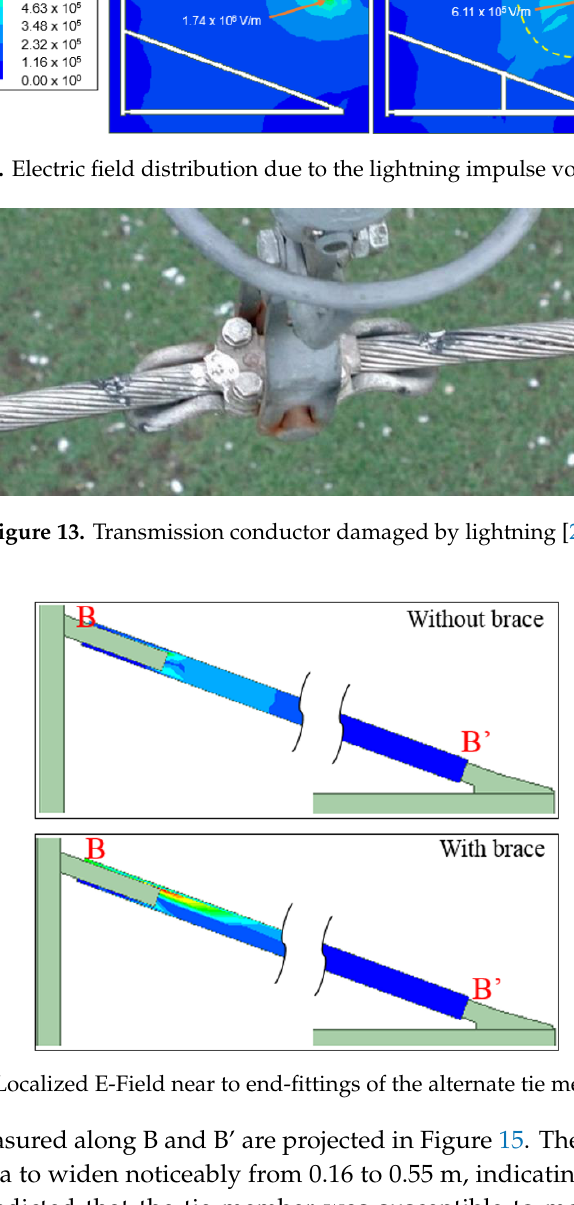
Figure 15. Changes of the E-Field profile and magnitude along B –B’ due to brace installation. On the contrary, a significant reduction of the maximum E-Field can be observed along the main member labeled A –A’ (see Figure 16). Figure 17 shows that the brace installation eliminated the E- Field spike near the end-fitting, causing the maximum value of E-Field to be reduced from 1.93 × 10 5 to 1.46 × 10 5 V/m, which indicates a 24.4% reduction. Subsequently, the middle part of the crossarm experienced a slight increase of the E-Field value that changed the overall profile of the E-Field, indicating a dome-like shape.